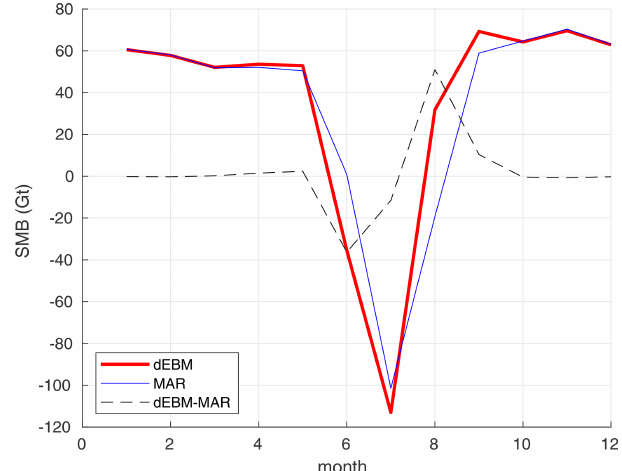
Figure 7. The 1980–1999 multiyear monthly means of the GrIS SMB in Gtyr − 1 as simulated by MAR (blue) and dEBM (red) and their difference (dashed